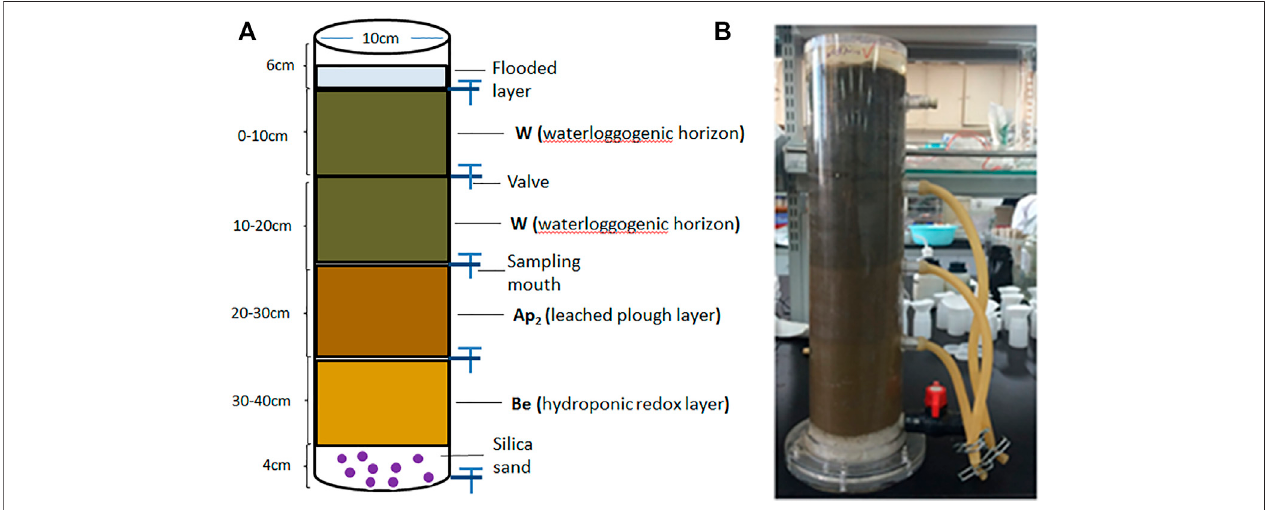
FIGURE 1 | Schematic diagram of the multi-layer soil column device used in the experiment.